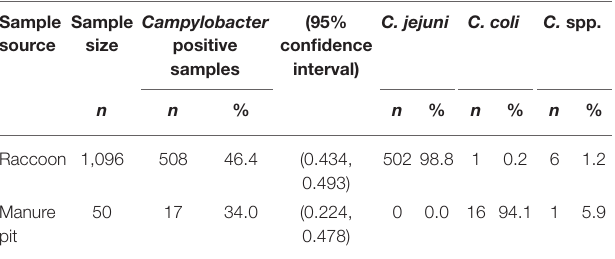
TABLE 1 | Frequency, prevalence and species of Campylobacter in fecal samples obtained from raccoons and swine farm manure pits. Campylobacter Sample Sample source size